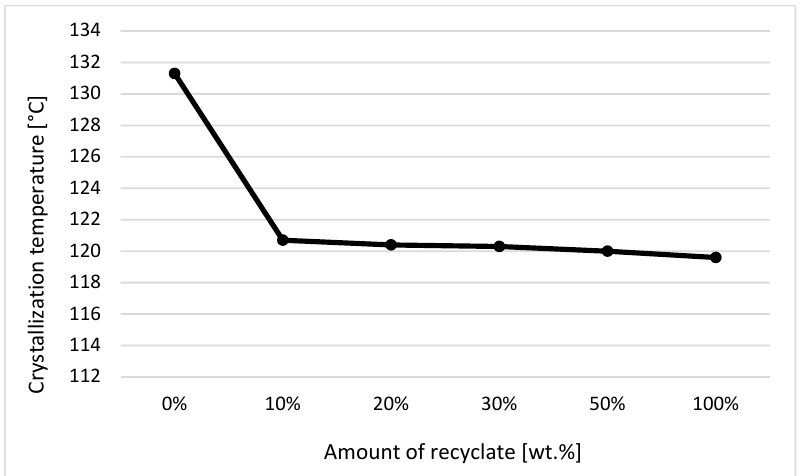
Figure 5. Dependence of the crystallization temperature on the proportion of weigh of the recycled material after exposure of samples to elevated temperature—component 1.